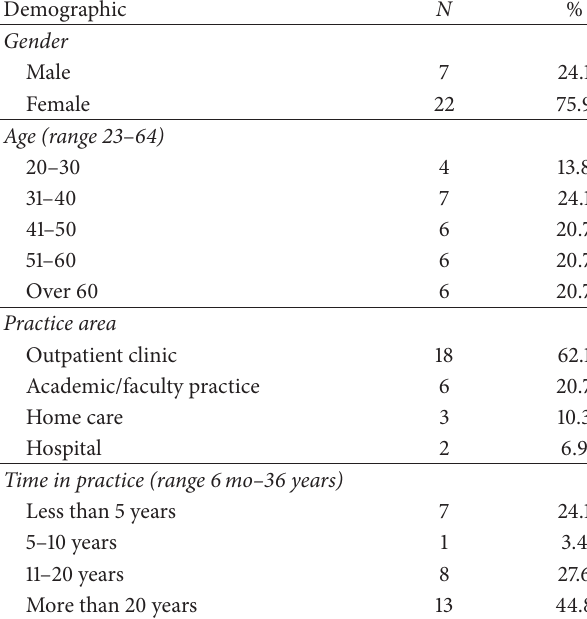
Table 1: Demographic information (the age ranged from 23–64 years with mean age being 41 years (SD = 10.3) and time in practice ranged from 6 months to 36 years).